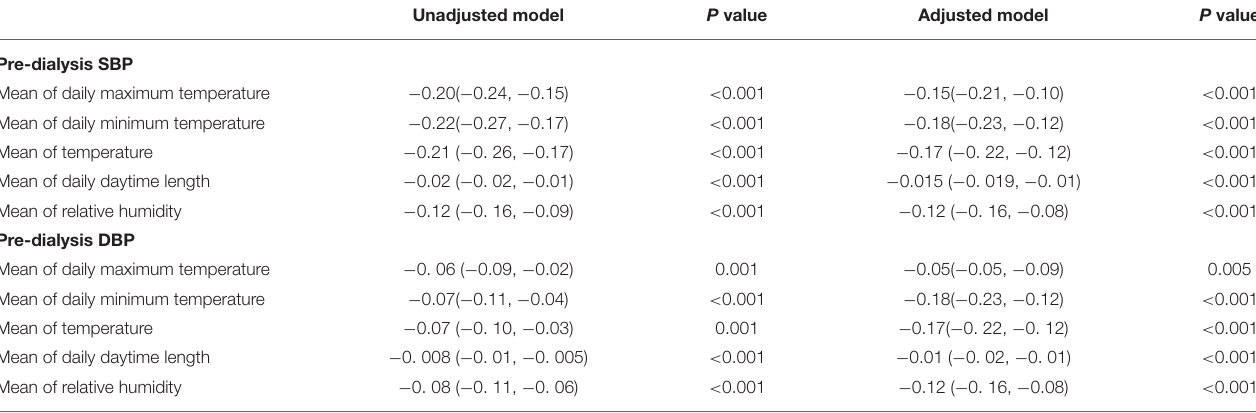
TABLE 5 | Association between pre-dialysis BP and climatic